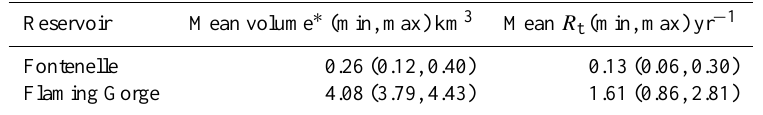
Table A1. Fontenelle and Flaming Gorge reservoir volumes and residence time ( R t ) for 2011. R t was calculated by dividing reservoir volume (volume, m 3 ) by yearly outflow ( Q out , m 3 yr − 1 ) . Mean residence time was based on mean Q out for 2011, including both base flow and snowmelt. Minimum residence time was based on Q out during snowmelt period of discharge. Maximum residence time was based on base flow Q out